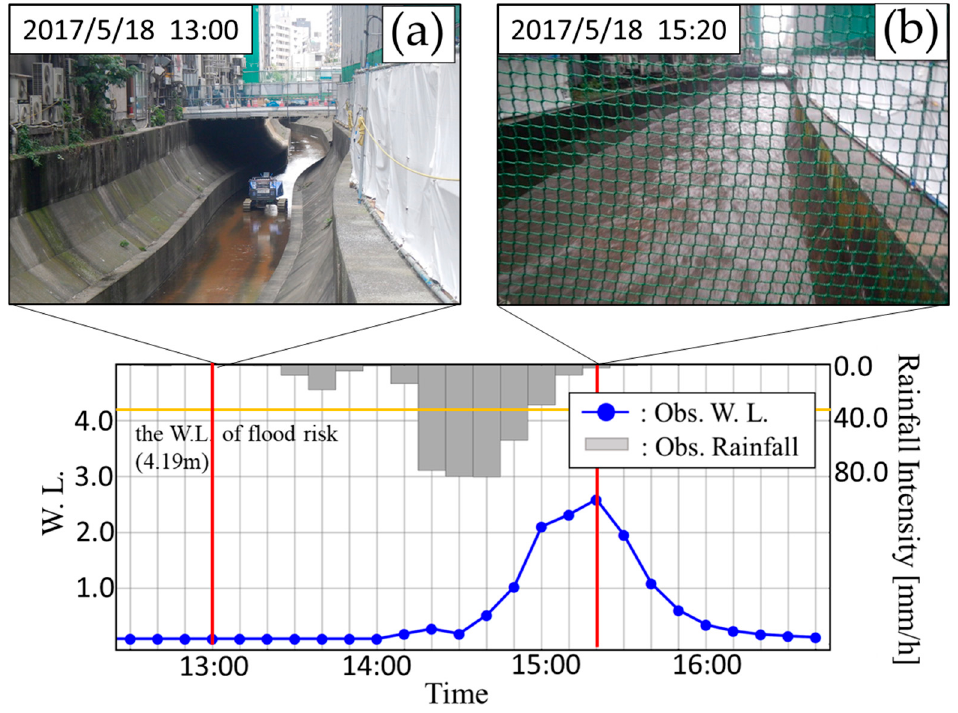
Figure 2. An example of localized torrential rain in Shibuya River Basin (18 May 2017). ( a ) State of the river during low conditions. ( b ) State of the river during of flooding There were nine torrential rainfall events were pinpointed. Figure 3 shows the rain- fall and water level during each torrential event as a graph. Meanwhile, Figure 4 shows the difference in the rainfall peak and water level peak for each torrential rainfall event. Then, Table 1 shows the data figures used in Figure 3, with the maximum rainfall and maximum water level for each event. In most torrential rainfall events, the difference be- tween the rainfall peak and water level peak was extremely short: 10–20 min. Next, the explanation about the observation data of rainfall and water level will be broken down. In Shibuya River Basin, there is one water level observation station [40] managed by To- kyo Metropolis (Figure 1b, orange circle), where observations are made every 10 min. As for the rainfall data, the rainfall observed data by the Xband-MP radar which installed by the Ministry of Land, Infrastructure, Transport and Tourism [41] were applied. Ob- servations were taken every minute, and the 10 min average was taken to match the time resolution of the water level meter. Figure 3. Localized torrential rainfall events since 2015 (9 Events).